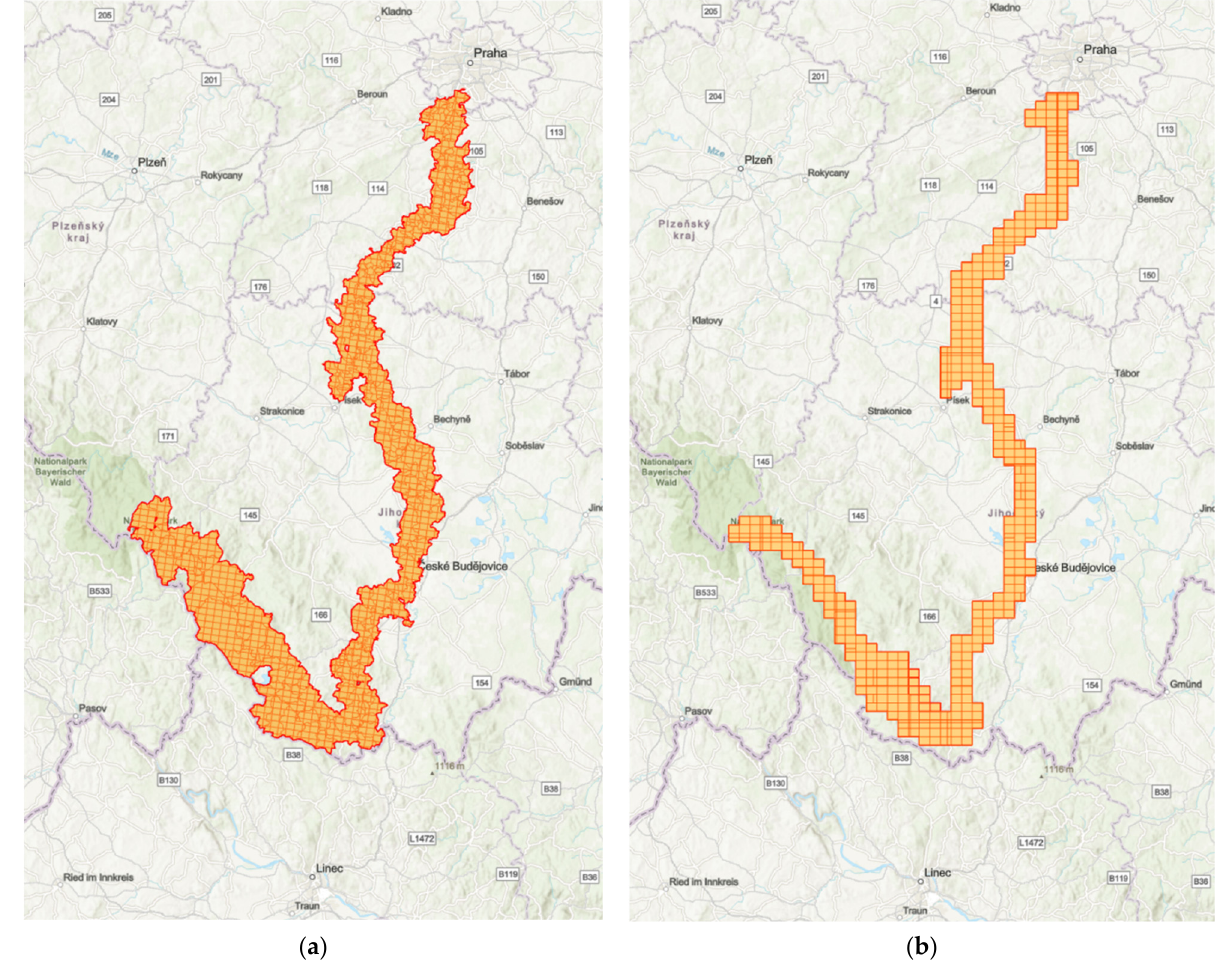
Figure 4. Display of the map sheets of old maps in the Vltava River valley from the capital of the Czech Republic, Prague, to the area bordering on Germany and Austria, used for vectorisation. ( a ) Imperial Obligatory Imprints of the Stable Cadastre 1:2880 used as input data for procedural modelling; ( b ) State Map 1:5000-Derived used as input data for the creation of a DTM.